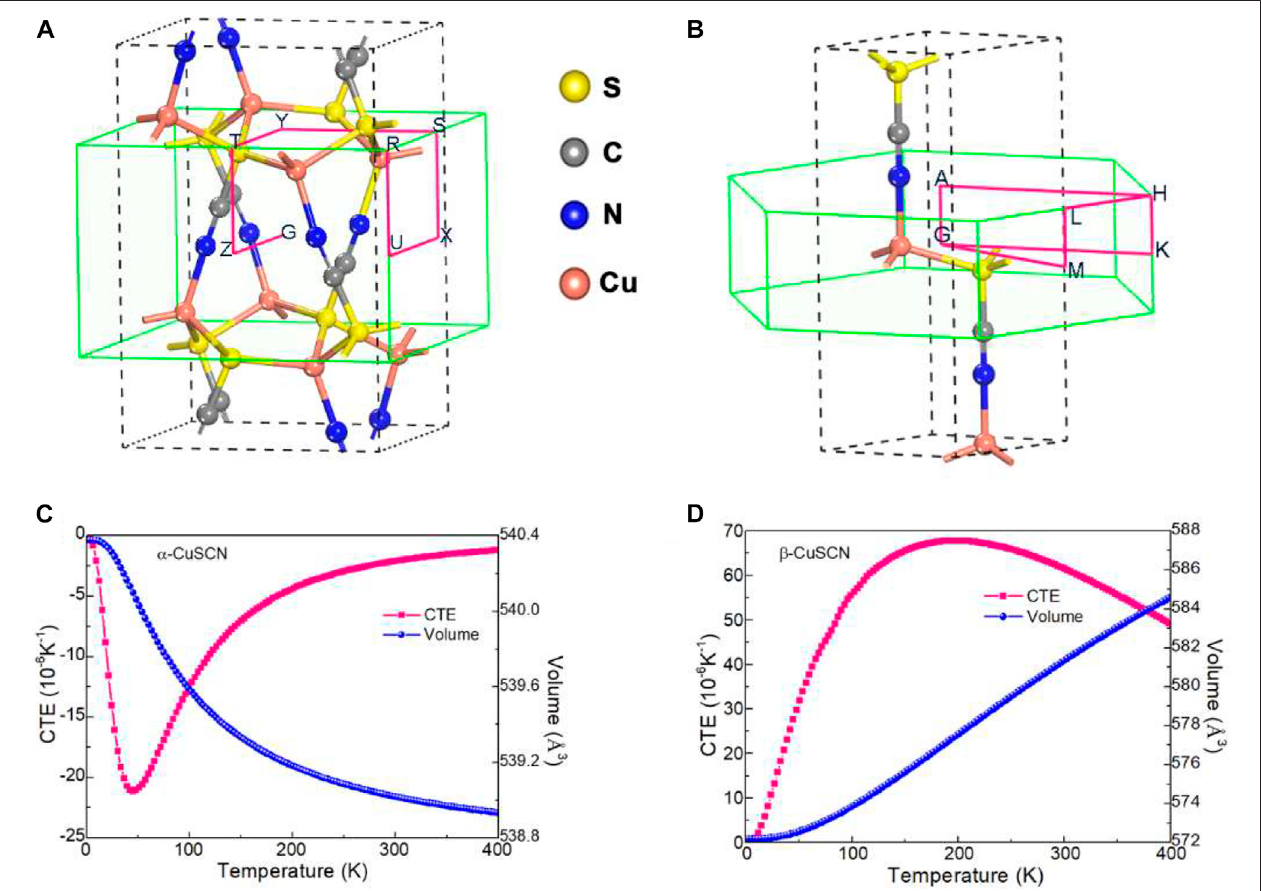
FIGURE 1 | Crystal structure of (A) α -CuSCN and (B) β -CuSCN. The fi rst Brillouin zone and the special k points used in band structure calculations are also presented. Temperature dependence of the cell volume and the CTE of (C) α -CuSCN and (D) β -CuSCN are given.